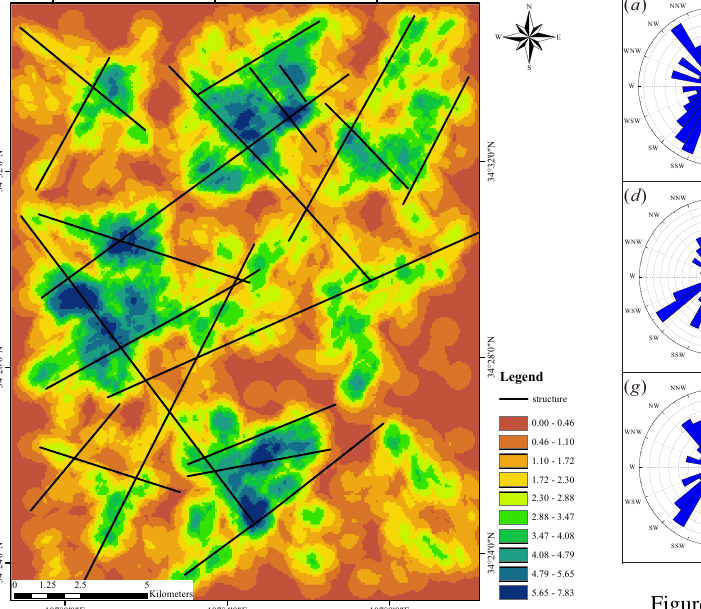
Figure 6. Lineaments density map